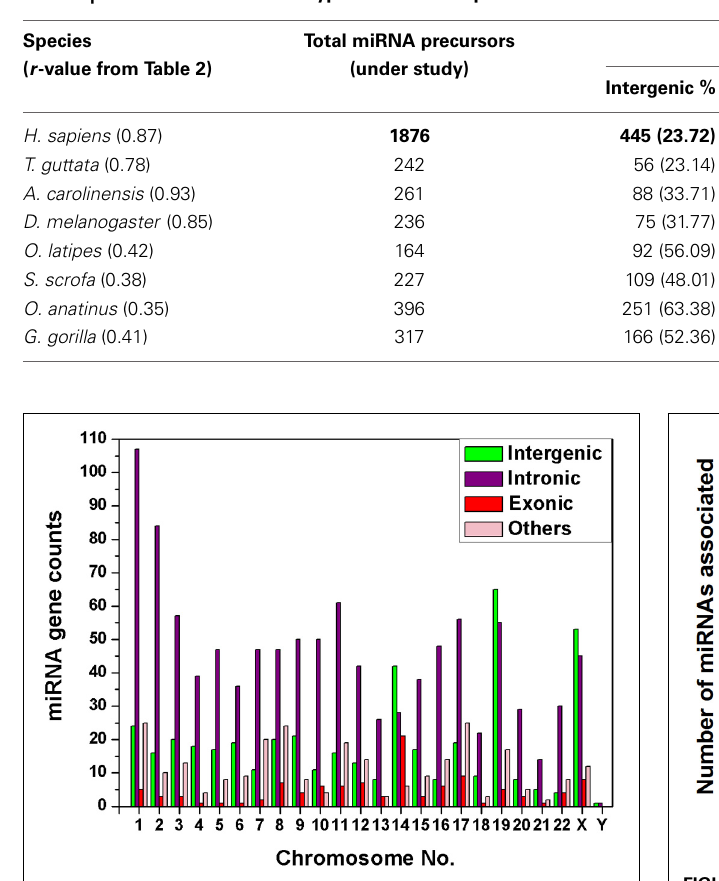
FIGURE 4 | Diversity of miRNA sub-types. The histogram depicts the variation of number of miRNA sub-types—intergenic, intronic, exonic, and others in each of the chromosomes of human genome.